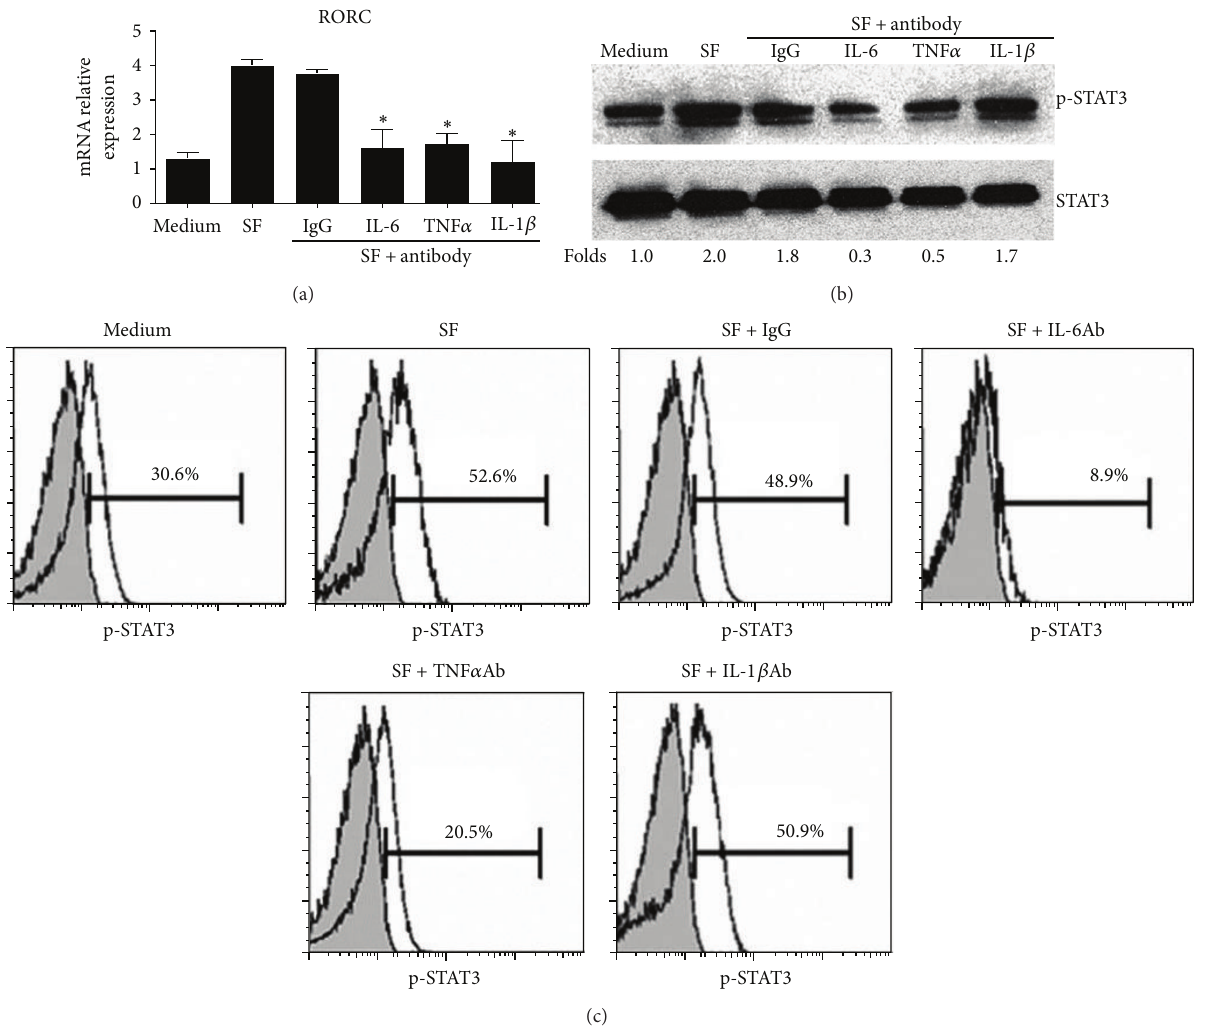
Figure 3: Enhanced Th17 cell differentiation by IL-6, IL-1 𝛽 , and TNF 𝛼 in synovial fluid through the STAT3 and RORC pathway. (a) PBMC preparations from healthy individuals were stimulated with anti-CD3/CD28 antibodies in the presence of the RA SF at dilution of 1: 8 pretreated with indicated antibodies and mRNA abundance of RORC was determined by real-time PCR after 18 h culture. Bars show the mean ± SEM. ∗ 𝑃 < 0.05 versus IgG control. (b and c) PBMC preparations from healthy individuals were stimulated with anti-CD3/CD28 antibodies in the presence of RA SF pretreated with indicated antibodies for 24h. The p-STAT3 and STAT3 levels were detected by western blot (b), or the p-STAT3 expression was analyzed by flow cytometry gated on CD4 + T cells (c). Data are representative of at least five separated